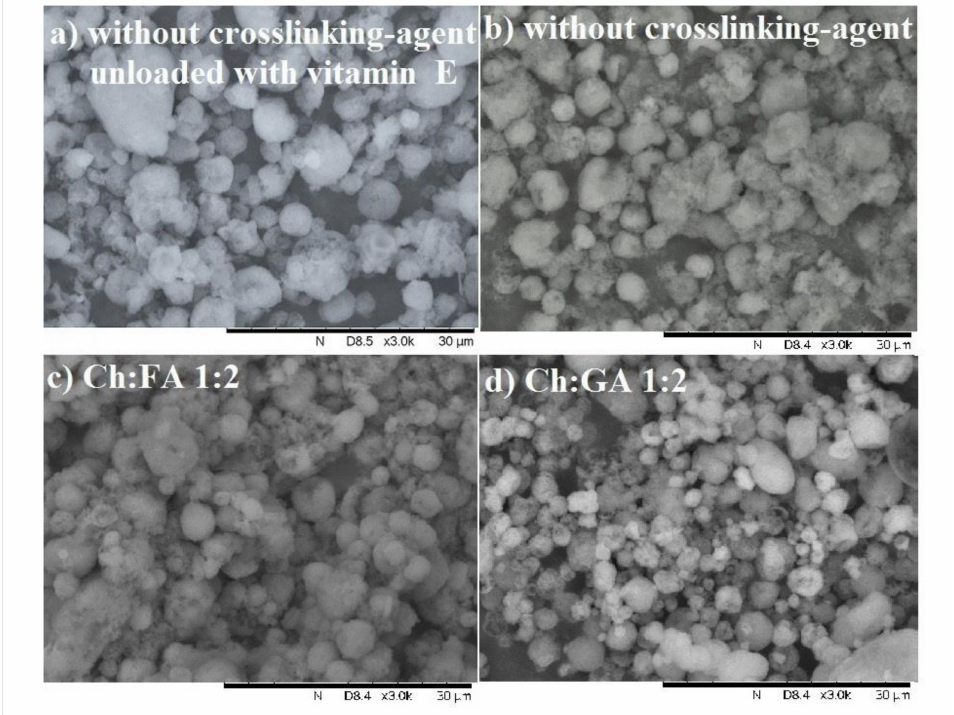
Figure 4. SEM photomicrographs of microcapsules obtained by spray drying of 20% oil-in-water emulsions stabilized with the Ch:SDS complex with or without cross-linking agent ( a ) unloaded and ( b – d ) loaded with vitamin E; magnification 3000 ×